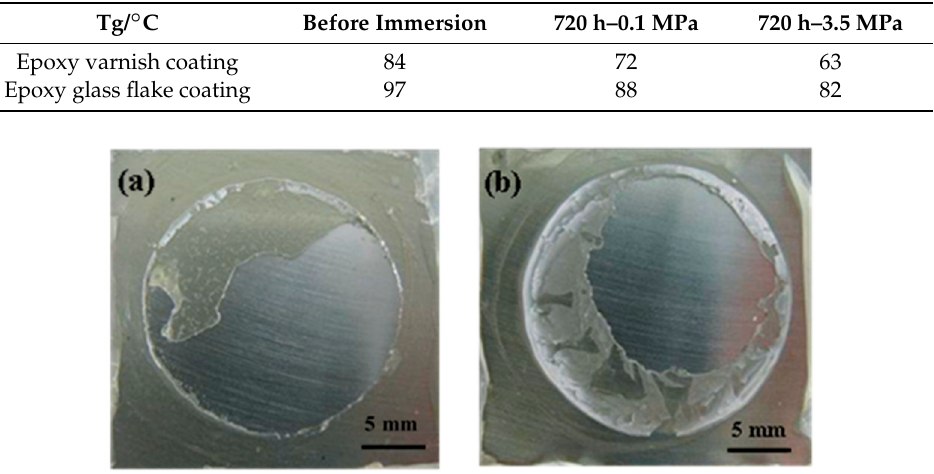
Figure 4. After pull off tests, the coatings have been released from substrates. The surface of substrates can been observed clearly. Macroscopic fracture morphology pictures of two coating/steel systems before immersion: ( a ) EV coating/steel; ( b ) EGF coating/steel.